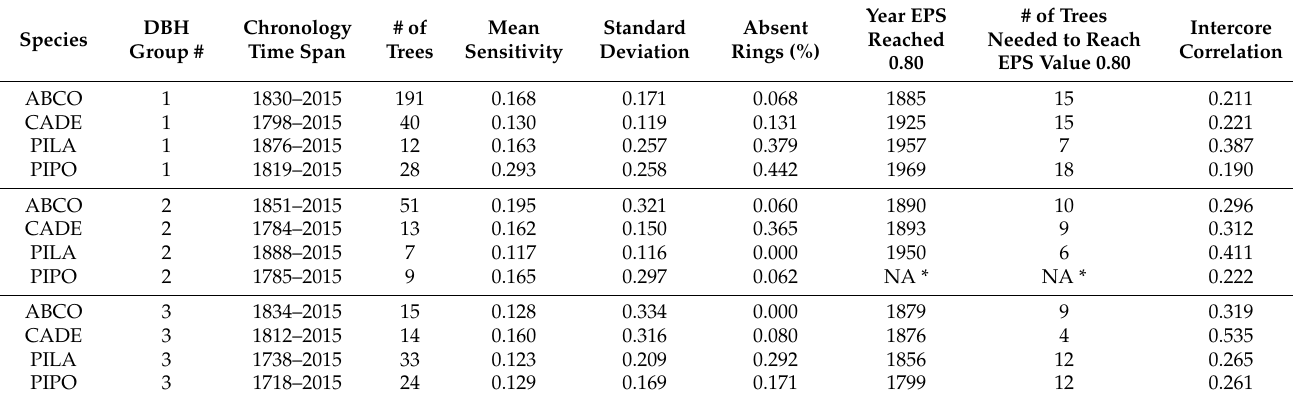
Table 2. Statistics for the standardized tree ring chronologies for each species and DBH group.